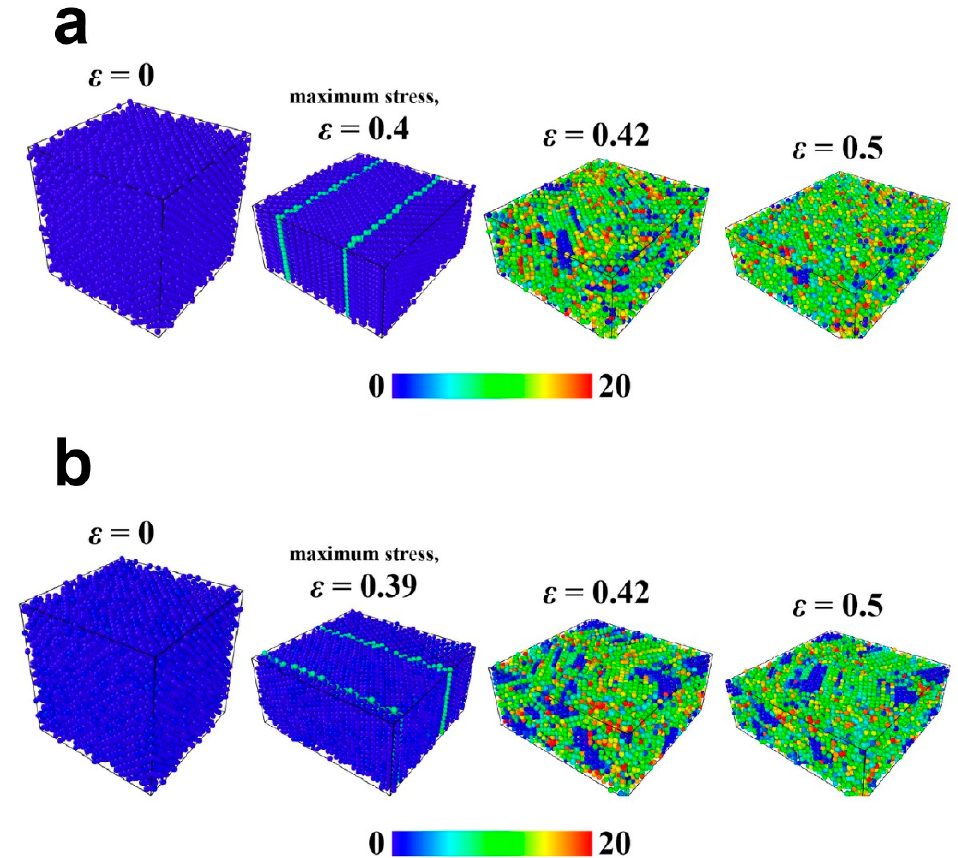
Figure 8. Atomic configuration for uniaxial compressive loading of TiAl alloy in the <001> direction at ( a ) 10 K and ( b ) 300 K. The atoms are colored according to the centrosymmetry parameter values calculated for the fcc crystal structure.